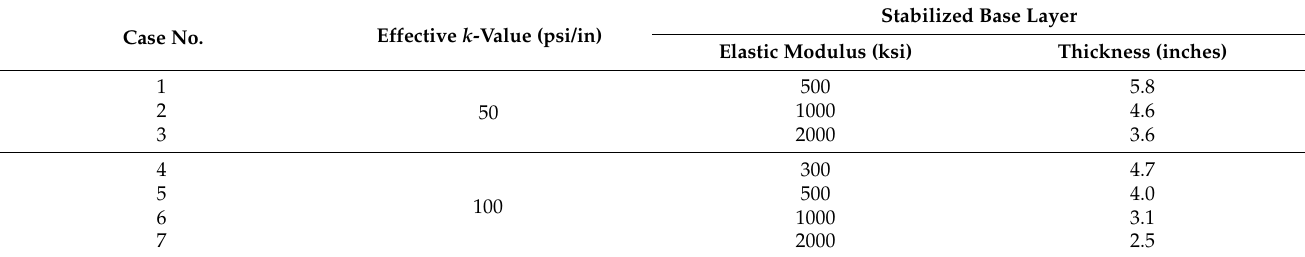
Table 7. Compositions for a desired composite k -value of 300 psi/in (1 in = 25.4 mm, 1 ksi = 6.89 MPa, 1 psi/in = 271 kN/m 3 ). Case No.